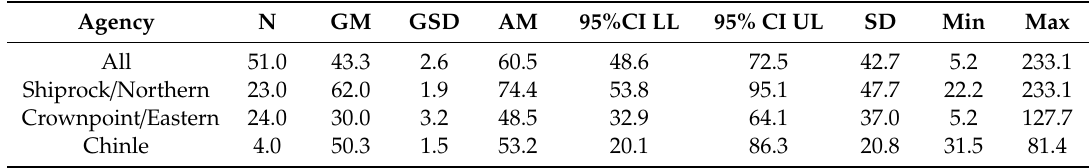
Table 5. Mean Indoor Radon Concentration [Bq / m 3 ] Levels by Navajo Nation Agency.